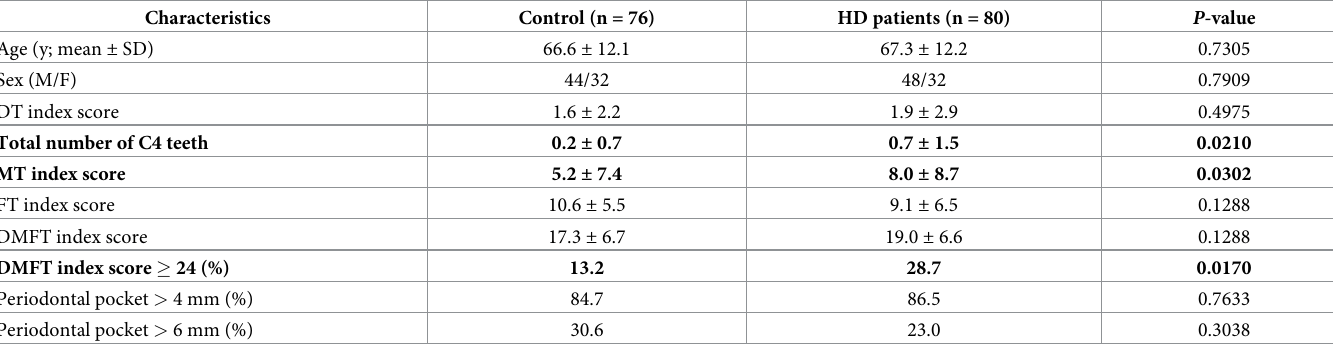
Table 1. Characteristics of patients on hemodialysis and